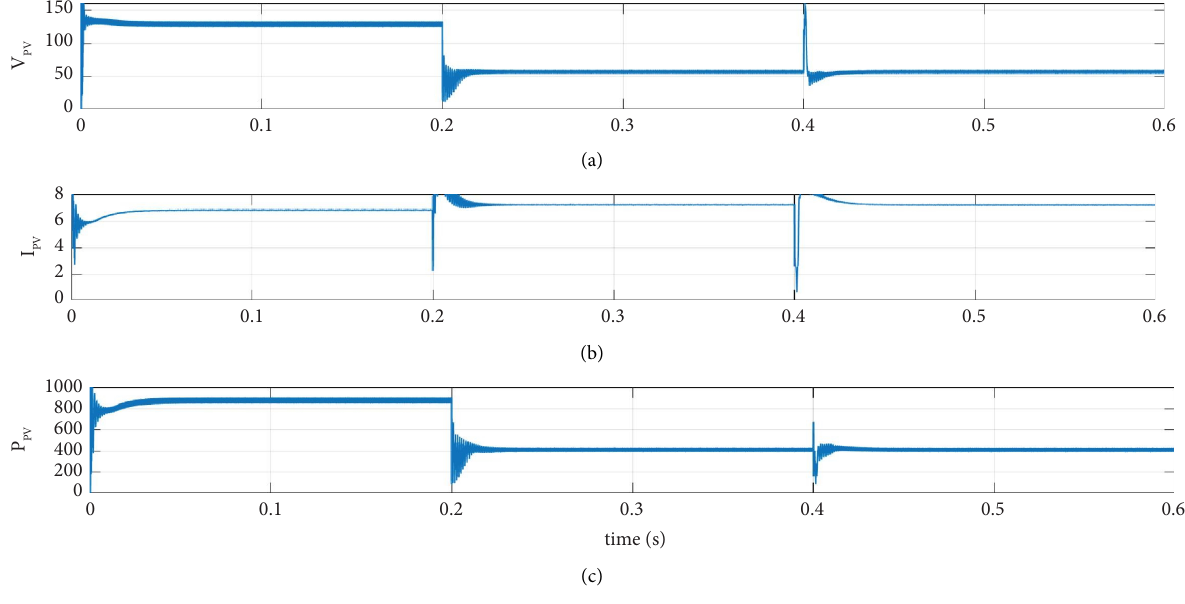
Figure 9: Simulation results (a) PV voltage (b) PV current (c) PV power.